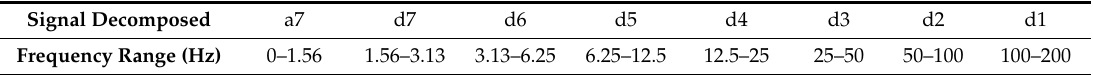
Table 1. Wavelet decomposition of vibration signals.